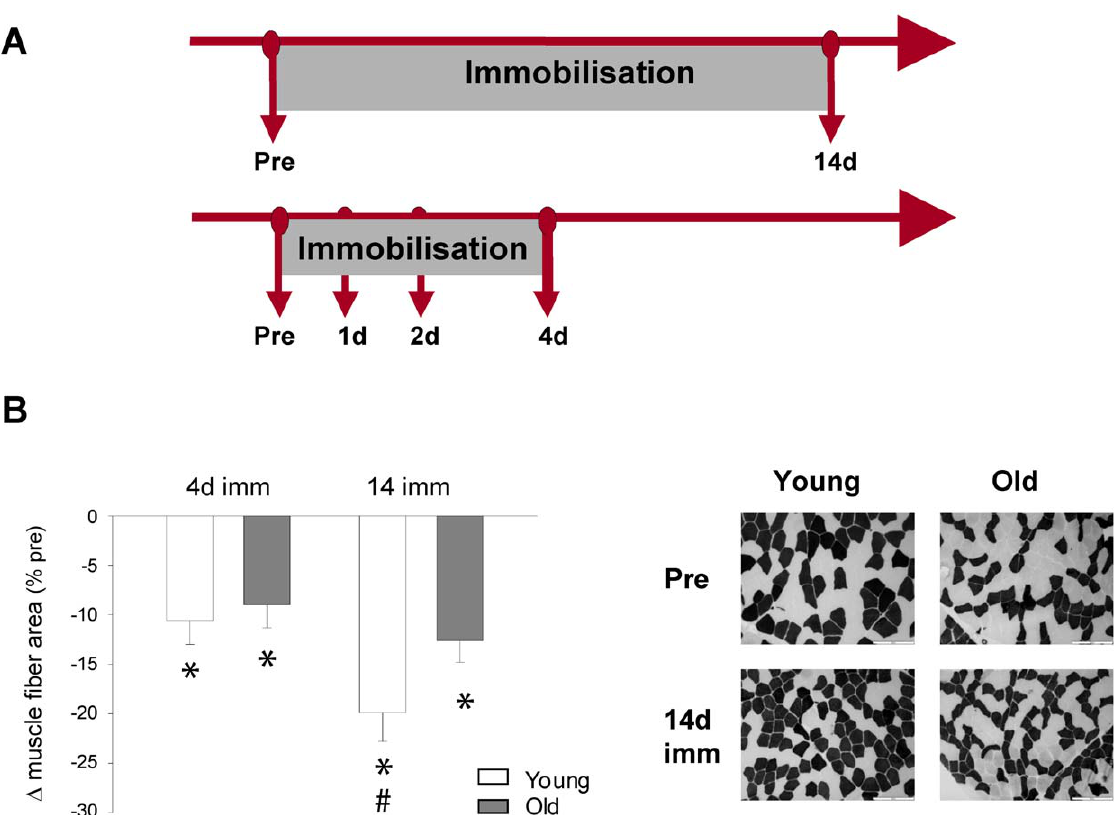
Figure 1. Immobility-induced skeletal muscle atrophy causes an age-specific decline in muscle size. A. Scheme of experimental setup, including the time points of muscle biopsy procedure. B . Percentage decreases in muscle size (mean muscle fiber area) after 4 days of immobility in young (n=11) and old (n=9) as well as after 14 days of immobilization in young (n=11) and old (n=12), respectively. * Time effect, p , 0.05 compared to pre, # Age effect, p , 0.05 young compared to old within time point. Group mean data 6 SEM. Mean myofiber area was assessed in the quadriceps femoris muscle, by muscle biopsy sampling. C. Muscle histology from resting state (pre) and immobility (14 d) was analyzed by myofibrillar ATPase at pH 10.3 preincubations demonstrating type I (white) and type II muscle fibers (black) [52].